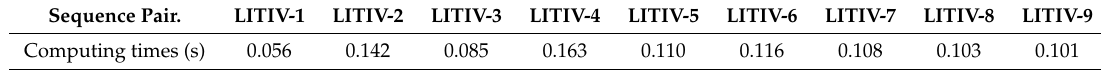
Table 3. Average computing time for one